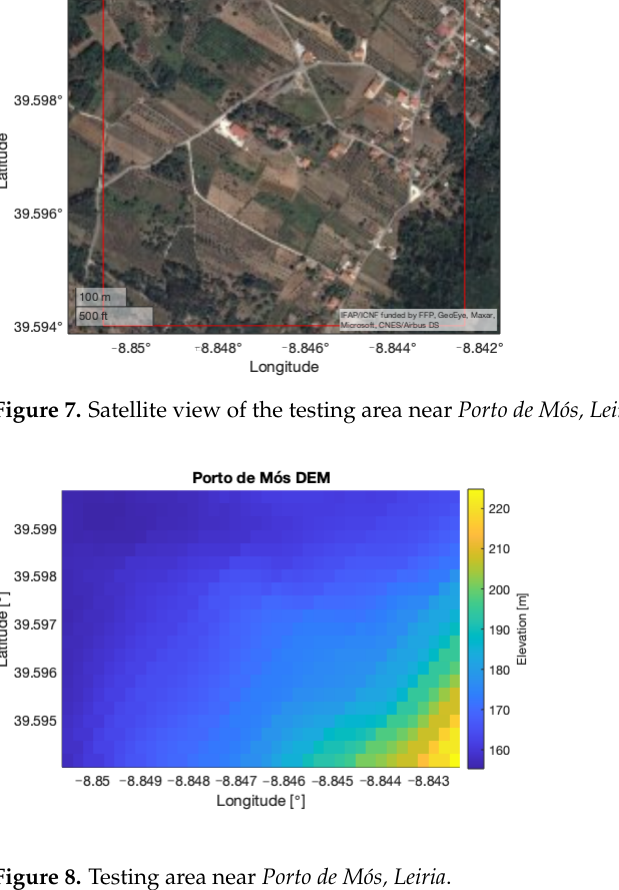
Figure 8. Testing area near Porto de Mós, Leiria . Table 5. Porto de Mós DEM